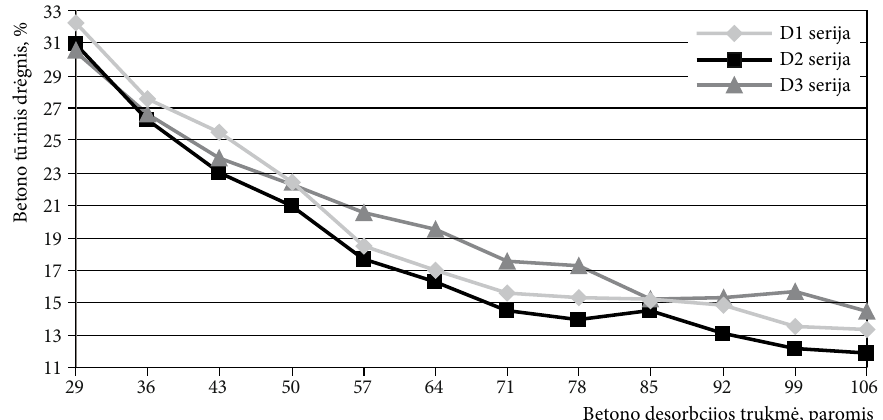
Fig. 4. Changes in concrete moisture under natural environment conditions ( t = +(20 ± 2) ° C; RH =